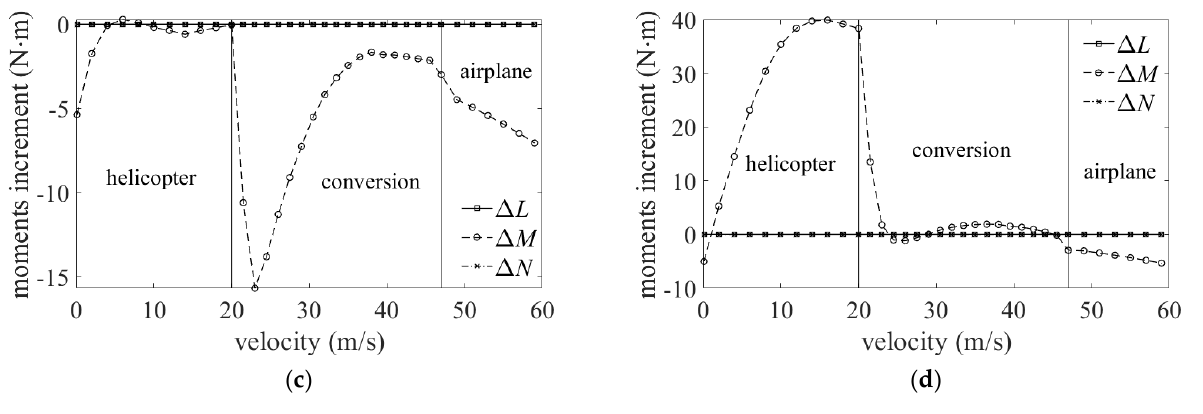
Figure 14. Influence on body moments with different interaction. ( a ) Body moments increment caused by rotor lateral interaction. ( b ) Body moments increment caused by rotor longitudinal interaction. ( c ) Body moments increment caused by rotor – wing interaction. ( d ) Body moments increment caused by total interaction. where Δ L , Δ M , Δ N represent the body moments increment along body axis.